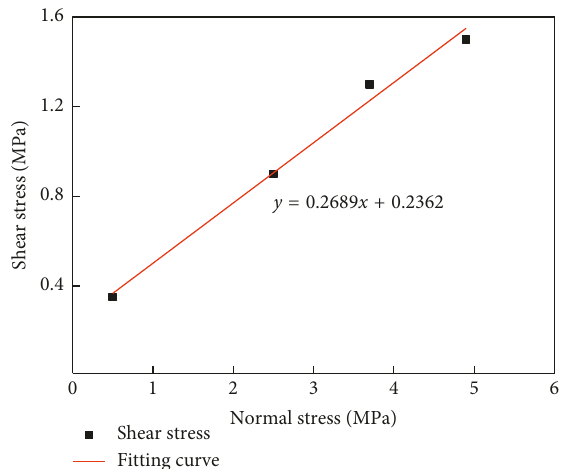
Figure 11: The relationship between the shear stress and the normal stress of the test point #1.